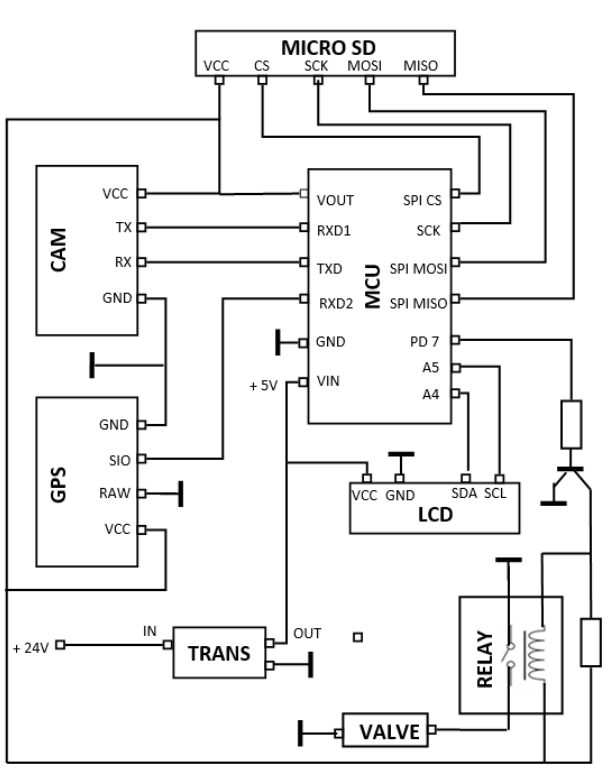
Fig. 3. Electrical circuitry of the proposed